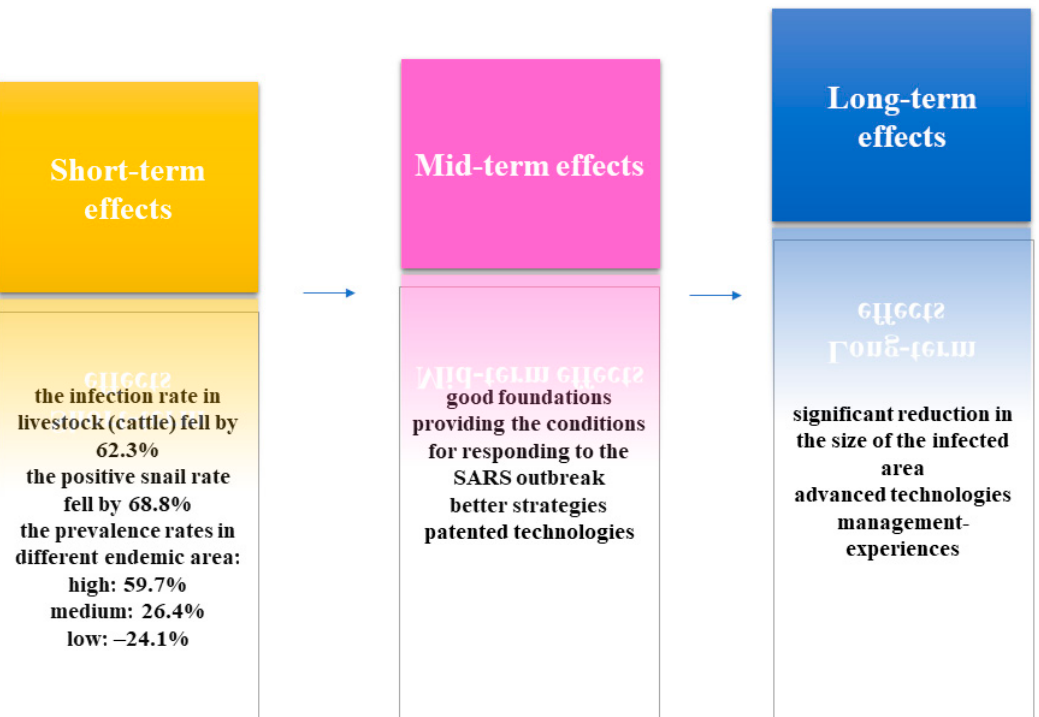
Figure 1. Short-, mid-, and long-term effects of the 10-year World Bank Loan Project (WBLP) for schistosomiasis control in the People’s Republic of China.